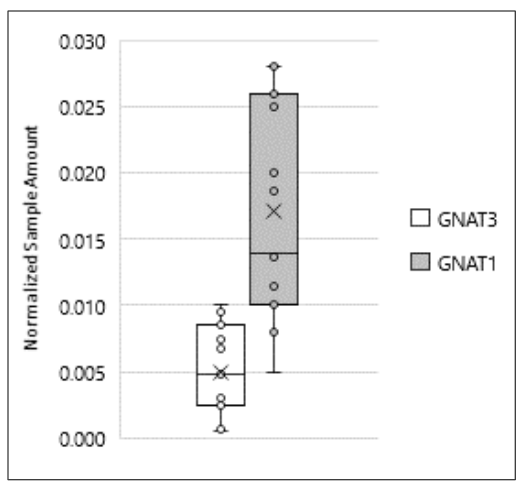
Figure 5. Expression of GNAT3 and GNAT1 in ejaculated human sperm. Graphical diagram is plotted as box–whisker plots, where boxes show the interquartile range with median and mean values, and whiskers represent min and max confidence intervals. Number of analyzed samples: testis: 6, sperm: 15.